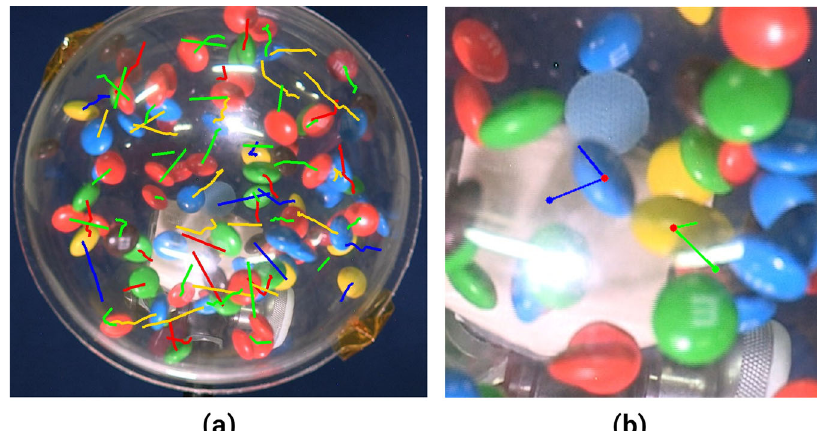
Fig. 3 Particl tracking. a Proximity-based particle tracking: the ellipsoidal particles are tracked by fi tting an ellipse to the individual objects in the image. The trajectories are reconstructed by linking the positions of nearest neighbors in two successive images. If particles get lost in the procedure, their trajectories are interpolated. b Collision tracking: a snapshot of one collision event: following the trajectory tracking, collisions fi tting with two-dimensional measurement are detected and analyzed. See supplementary videos collision1.avi and collision2.avi for complete events.